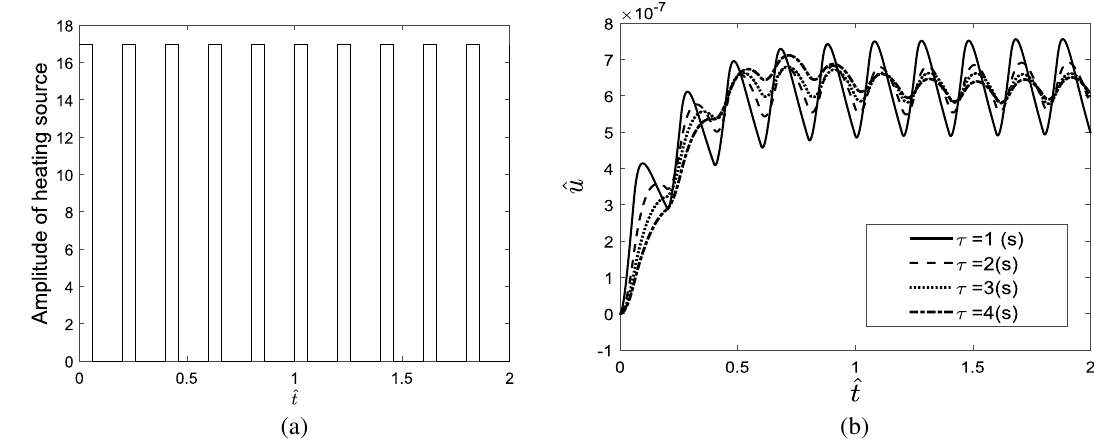
Figure 6. ( a ) Repetitive pulse heating source, ( b ) displacement response of the skin tissue considering different relaxation times.